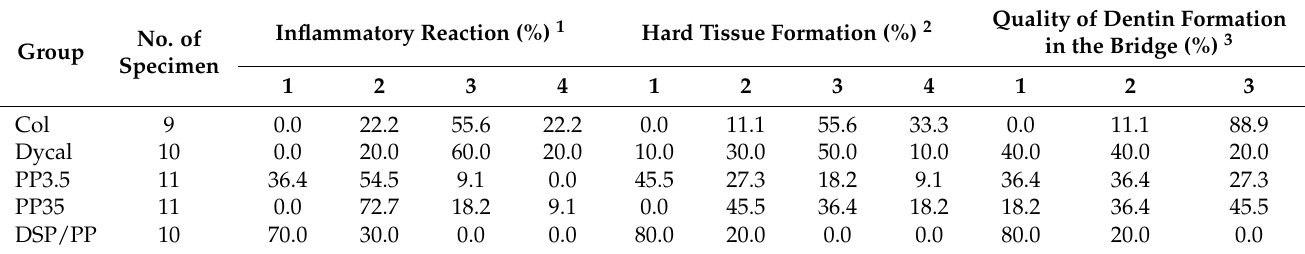
Table 2. Scoring of histological findings of pulps capped with different test